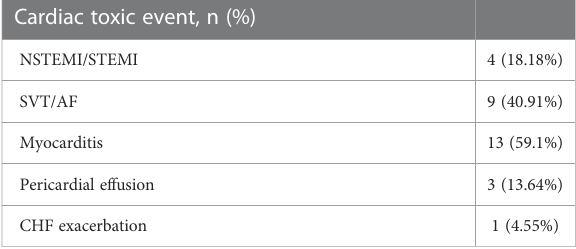
TABLE 4 Cardiac toxic events strati fi cation in 22